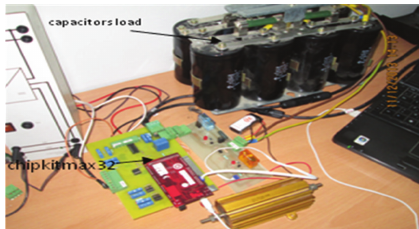
Figure 7: Implemented system.